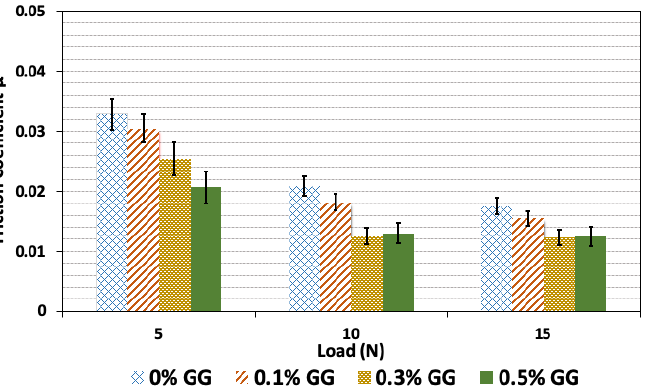
Figure 5. The average friction coefficient, μ, for PVA and PVA/GG hydrogel with different GG contents. The results are shown for measurements under three different loads and at a sliding velocity of 0.2 m/s.